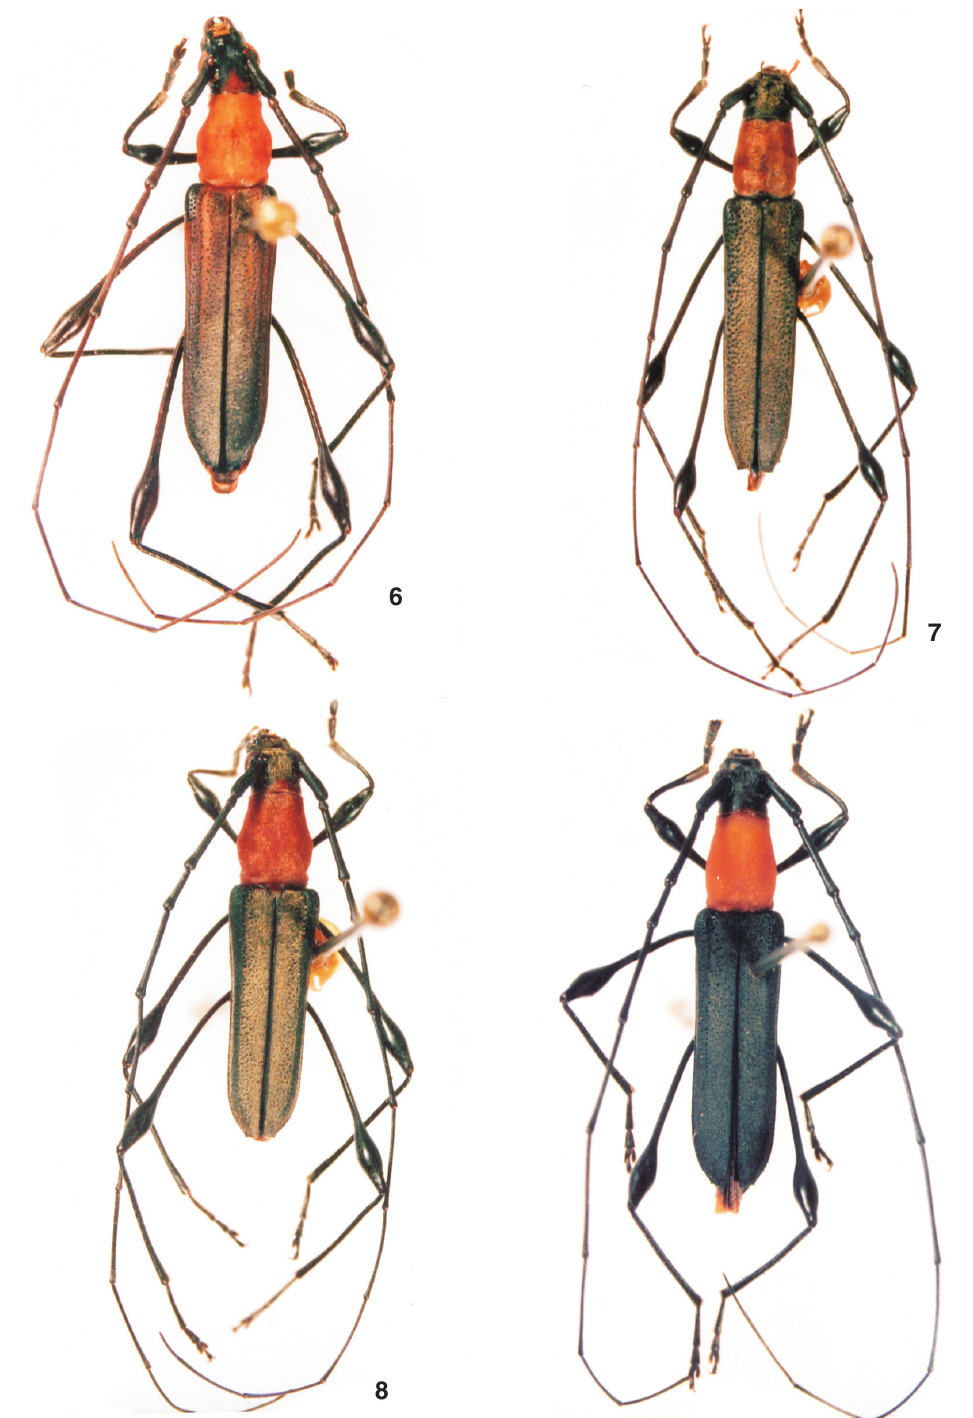
Figuras 6-9. Habitus: (6) Rhopalophora collaris , macho, 12,9 mm; (7) R . prolixa , parátipo macho, 11,0 mm; (8) R . occipitalis , macho, 10,5 mm; (9) R . paraensis , parátipo macho, 11,3